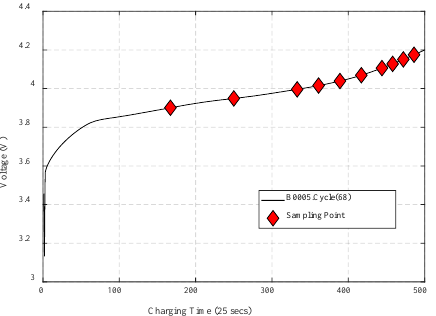
Figure 3 . An example of importance sampling (IS) in charging voltage.